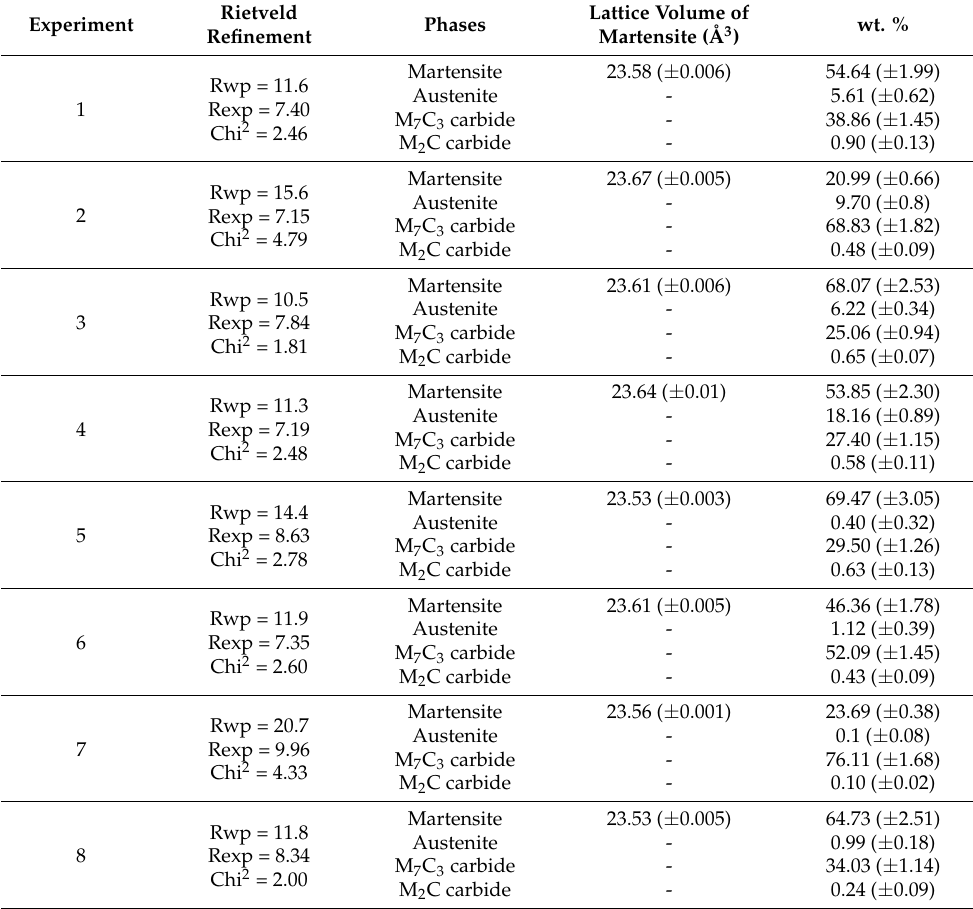
Table 4. Distribution in weight of carbides, martensite and austenite, and cell volume of austenite. Statistical error is indicated in